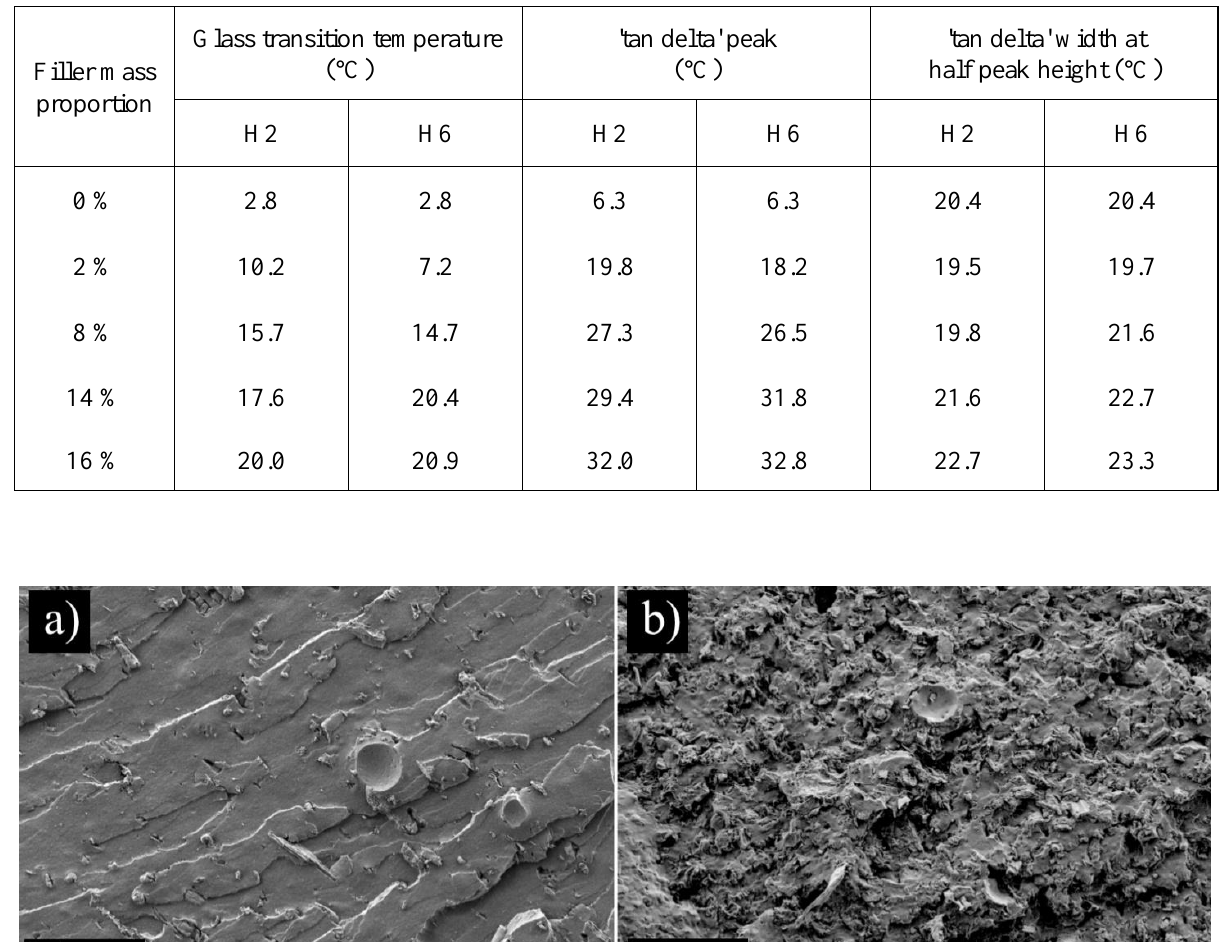
Table 2. Summary of DMA results.